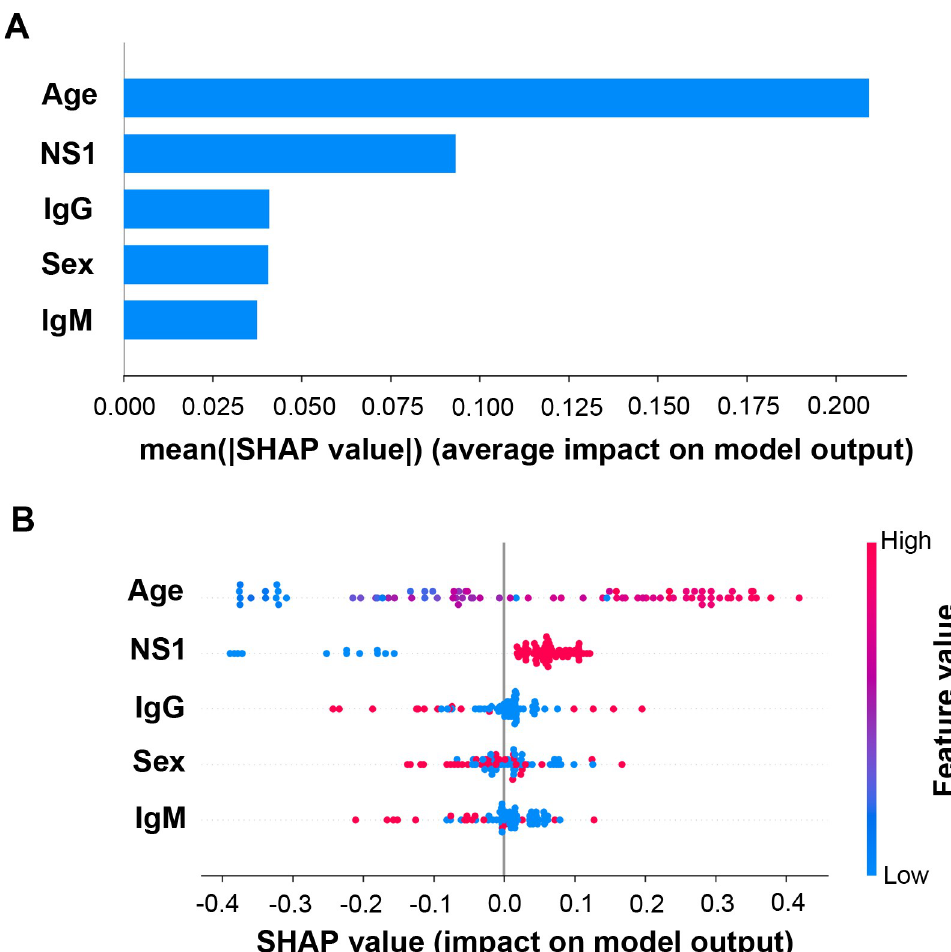
Fig 2. Importance plot and summary dot plot of the ANN model using SHAP explainer. (A) Importance plot depicting the features most effective at predicting dengue disease outcomes. (B) Summary dot plot mapping the effects of the indicated features on prediction outcomes, which assigns features to continuous color for age, and discrete color for other features. For NS1, anti-DENV IgM, and anti-DENV IgG, positive is red, and negative is blue; For sex, male is red, and female is